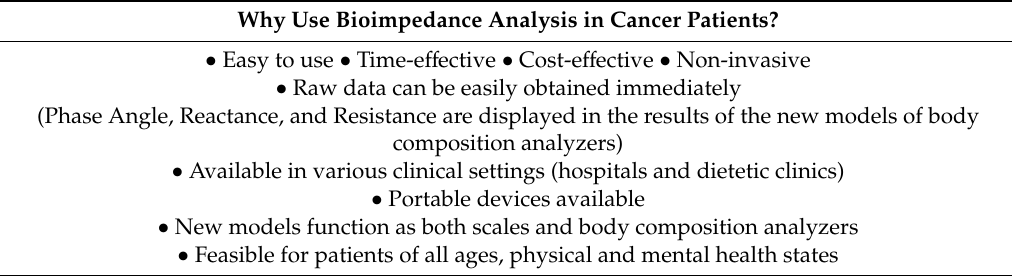
Table 1. The advantages of using bioimpedance analysis in cancer